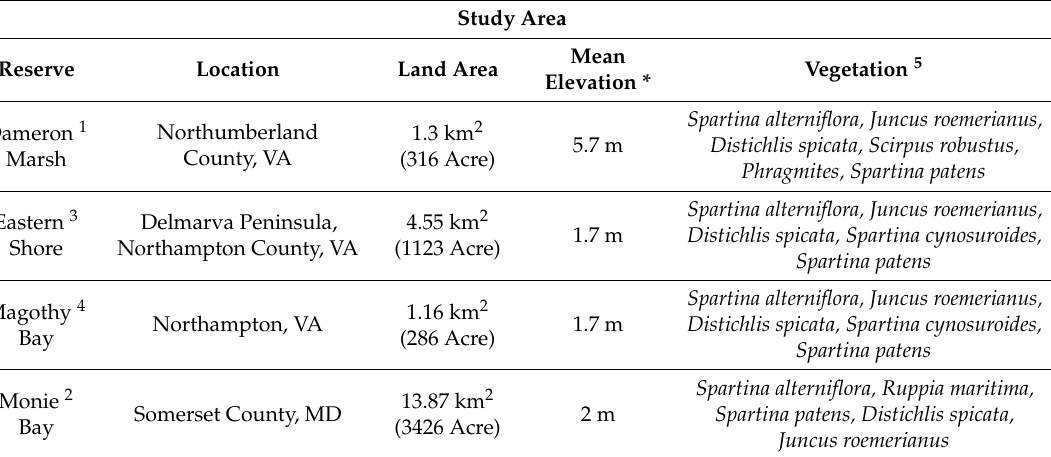
Table 1. Summary chart of the four study sites.